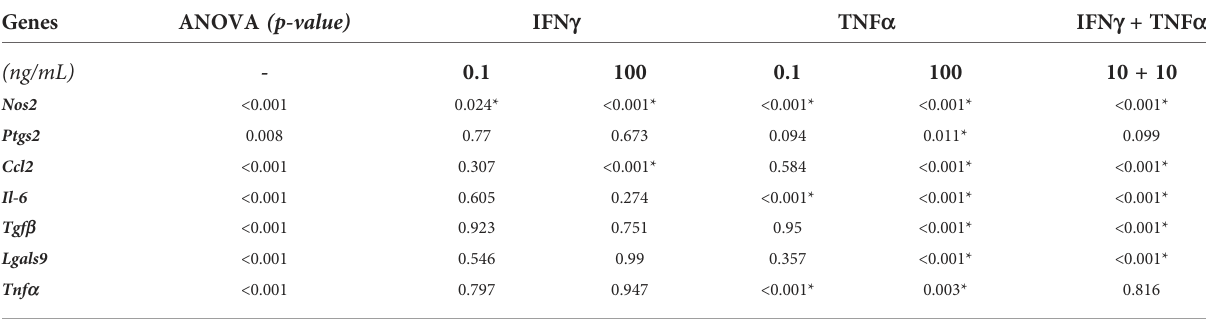
TABLE 1 AD-MSC licensing through IFN g and TNF a treatment. Holm-Sidak Pairwise Comparison (vs. Control) (p-value)